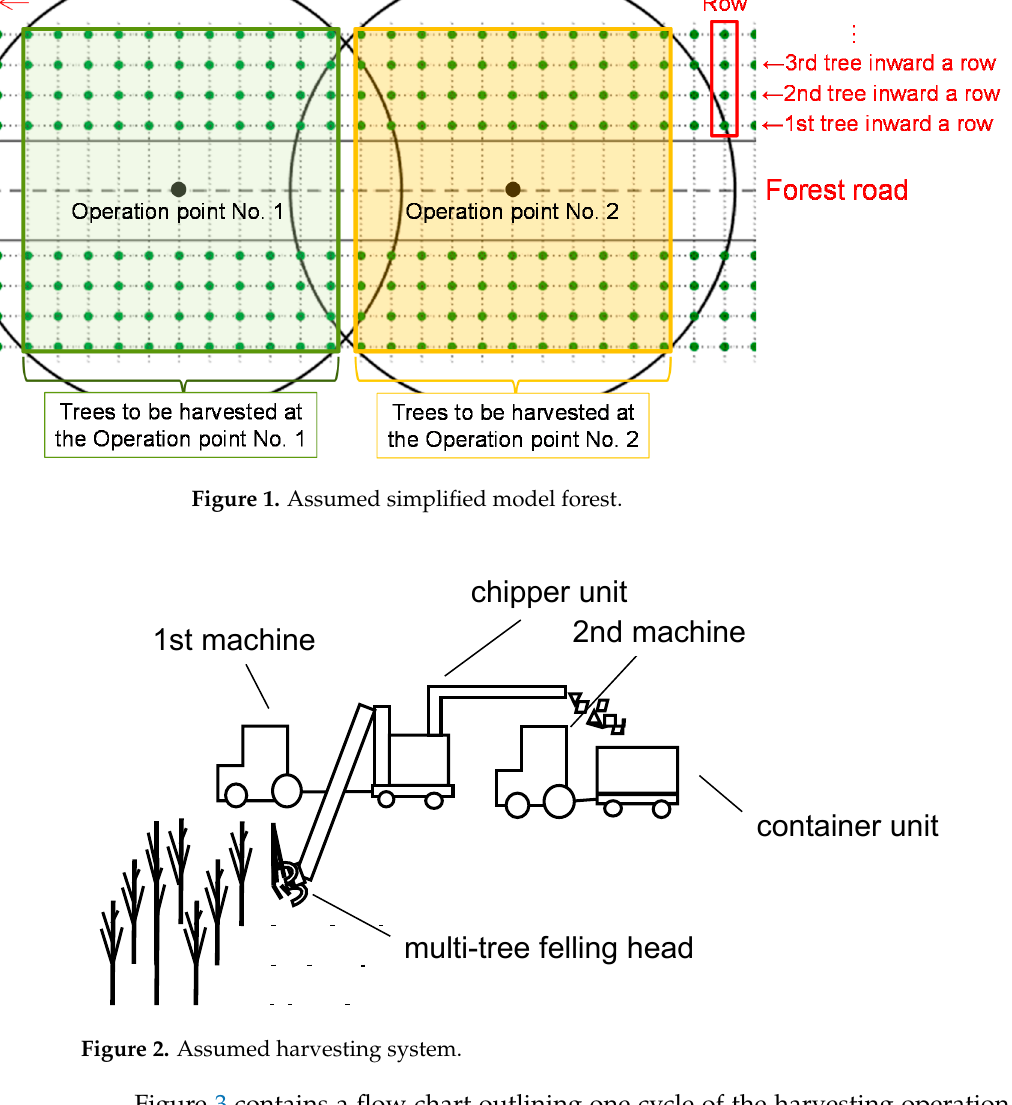
Figure 2. Assumed harvesting system.